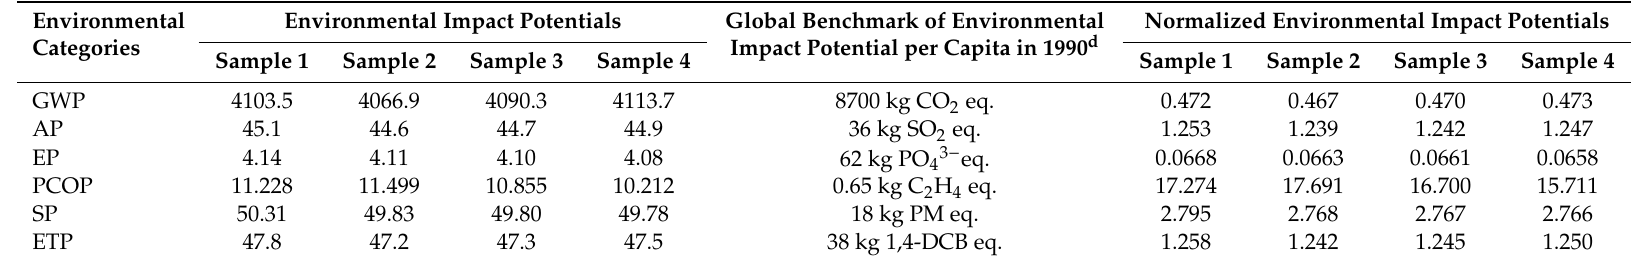
Table 3. Total and normalized environmental impact